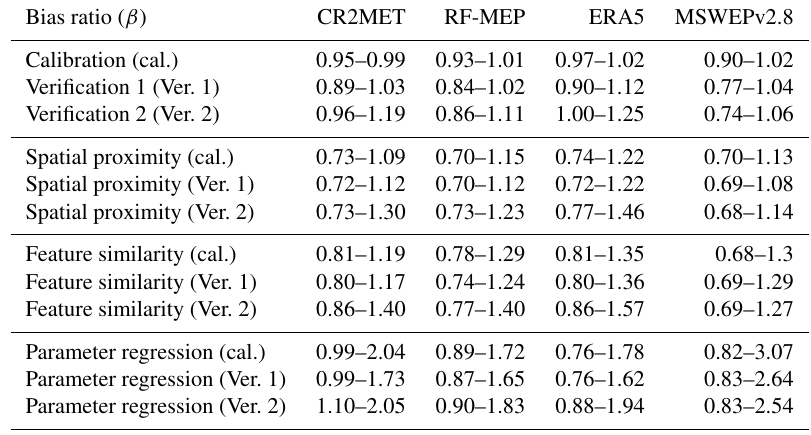
Table C2. Quantiles 0.25 and 0.75 of the bias ratio ( β ) of the KGE (cid:48) over the selected catchments.